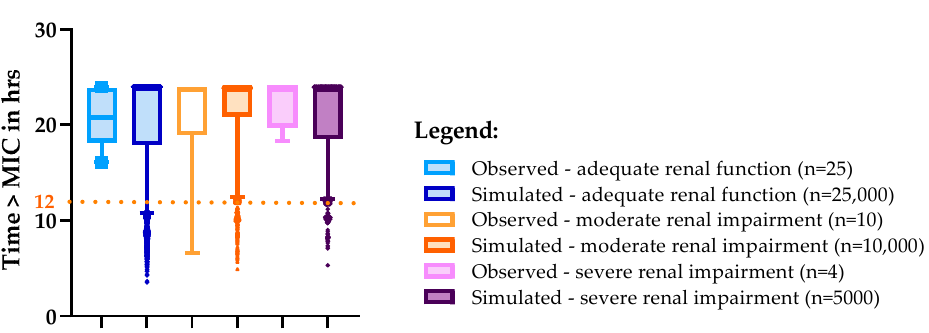
Figure 2. Boxplots of observed and simulated time above target for MIC 8 mg/L for patients with adequate, moderately impaired and severely impaired renal function within the first 24 h of treatment. Presented are the median (horizontal line within the box), the interquartile range (box) and the 5th and 95th percentile (whiskers). The target for 50% T > MIC 0–24 is presented as the orange dotted line at 12 h.